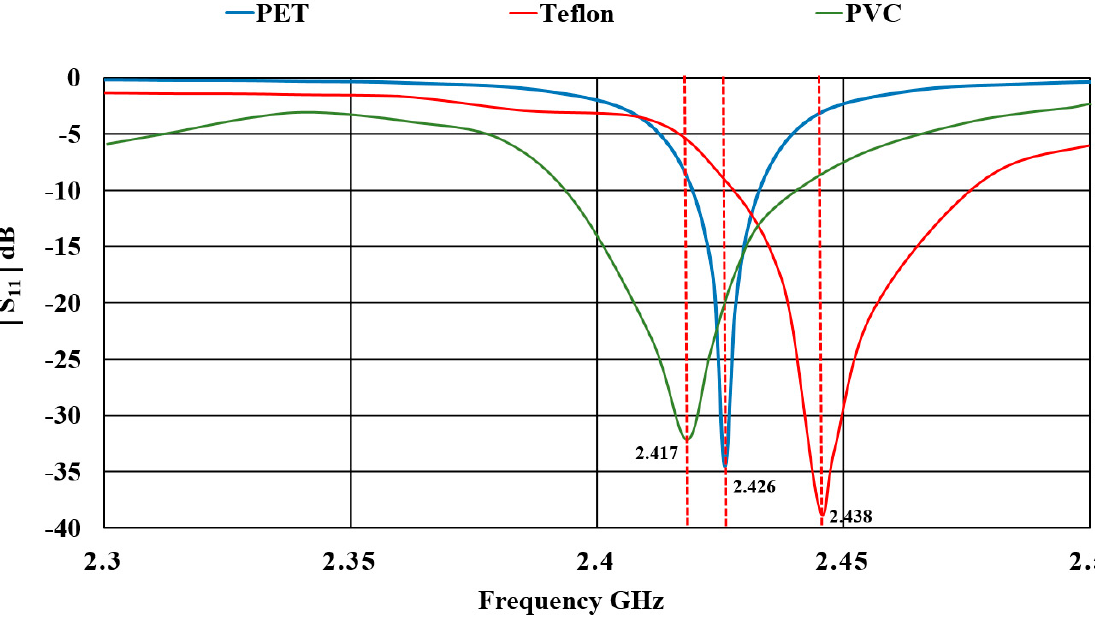
Figure 9. Reflection coefficients of E-shaped flexible polymer substrate antennas on PET, Teflon, and PVC substrates operating at 2.45 GHz.